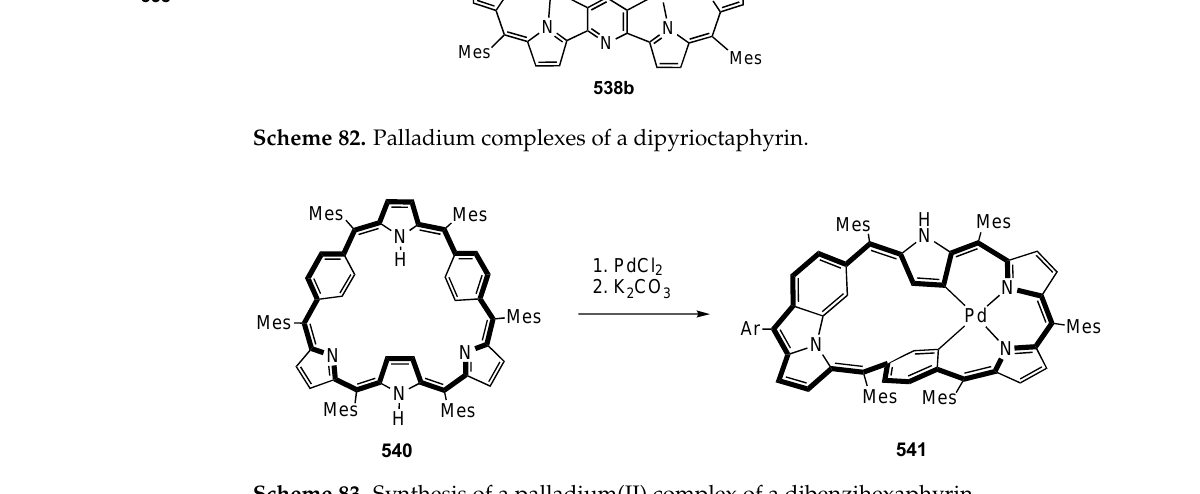
Scheme 83. Synthesis of a palladium(II) complex of a dibenzihexaphyrin.